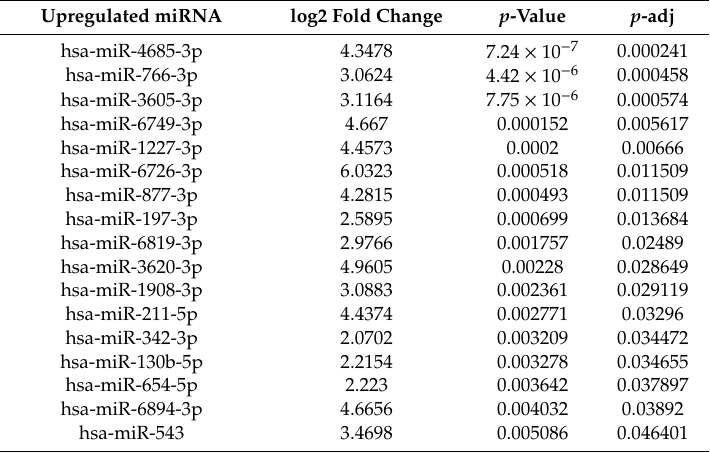
Figure 1. Volcano map of the differentially expressed miRNAs. The left part shows the downregulated miRNAs, and the right part indicates the upregulated miRNAs in the DD Group versus the Control Group (y-axis represents p value; x-axis represents log2 fold change). Table 3. Dysregulated miRNAs in patients with lumbar disc herniation (Disc Degeneration Group) versus the Control